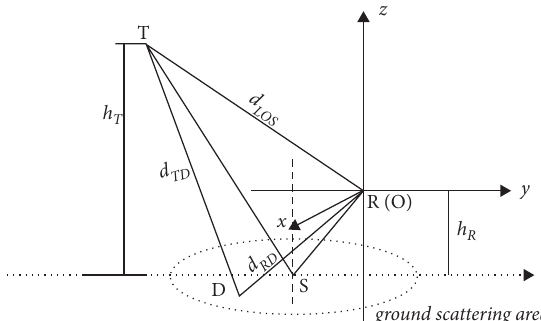
Figure 1: The geometrical structure of the system model with flat Earth surface as the scattering